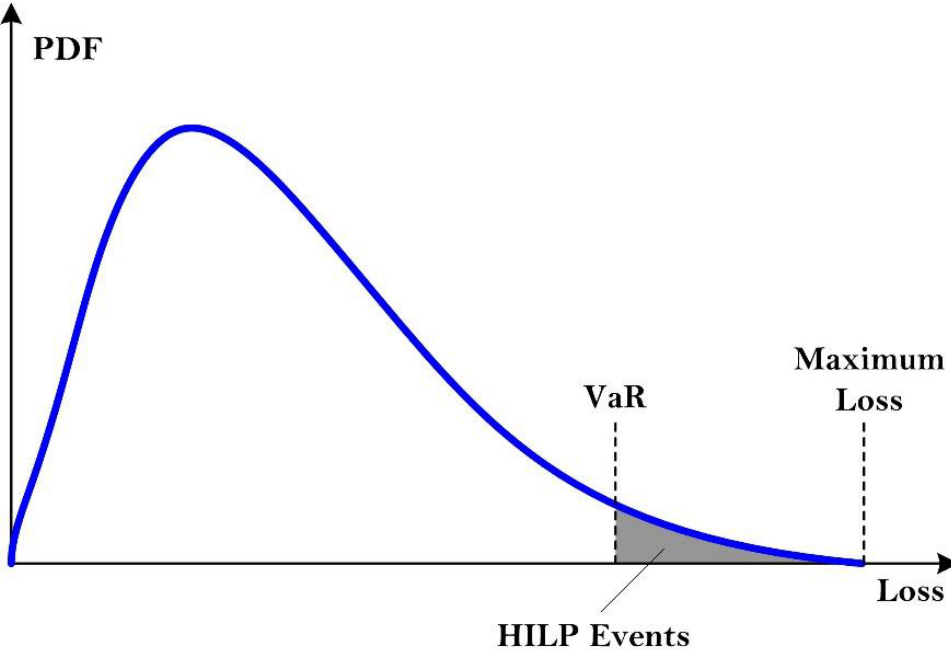
Figure 6. VaR and CVaR evaluation for a heavy-tailed probability density function.